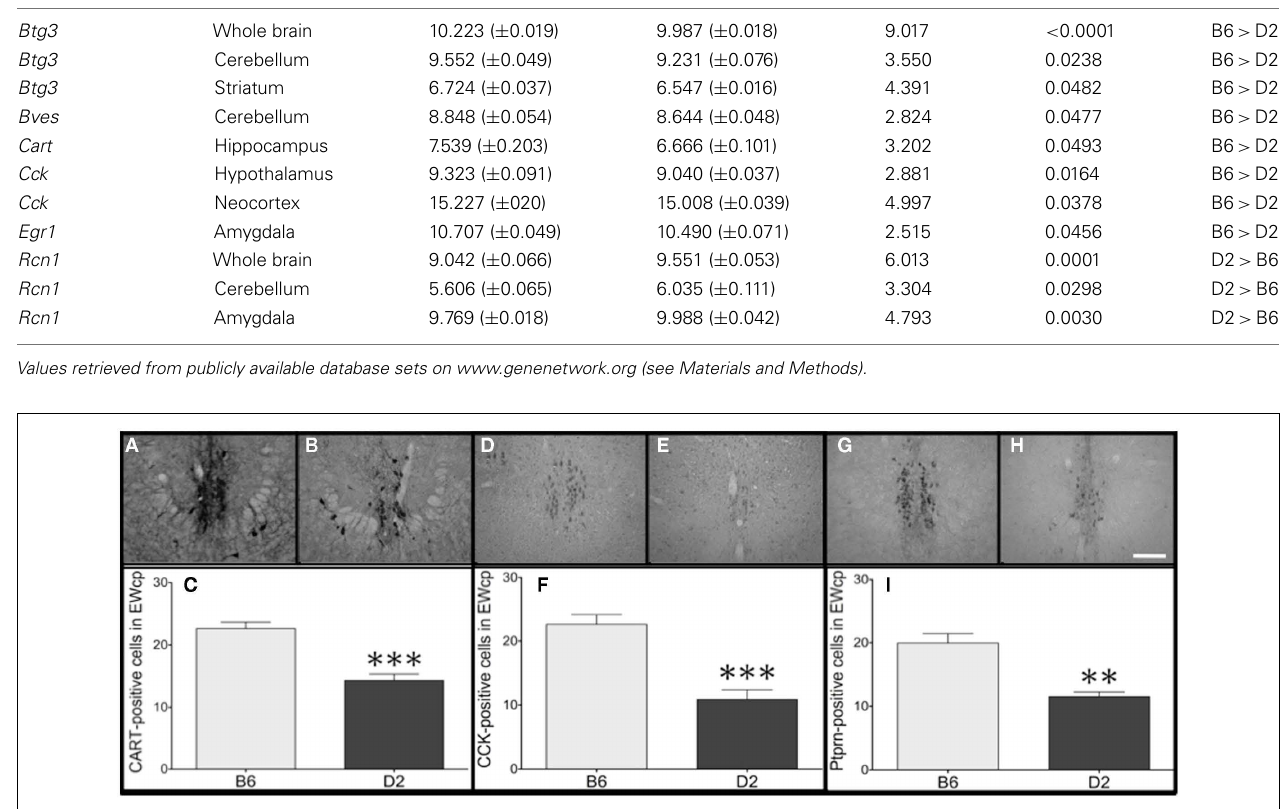
of neurons immunoreactive for (C) CART, (F) CCK, and (I) Ptprn were found within B6 mice, relative to D2 mice. Scalebar = 500 μ m, valid for all representative images. ** p = 0.0002; *** p <